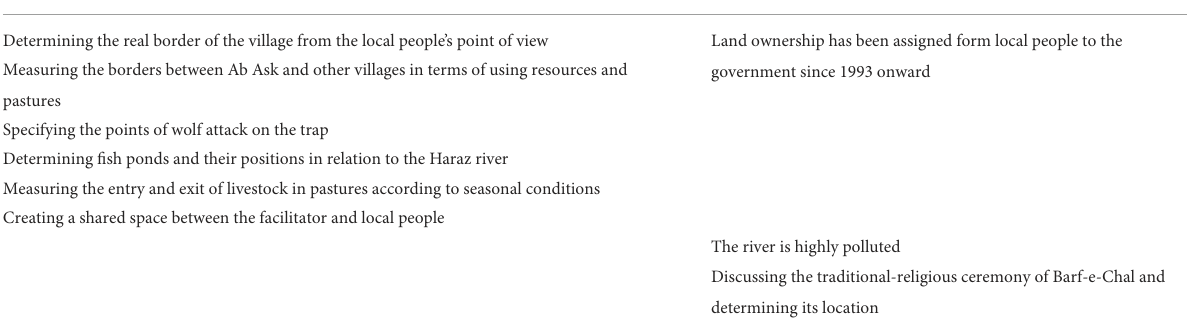
TABLE 1 Results of natural and social resource mapping